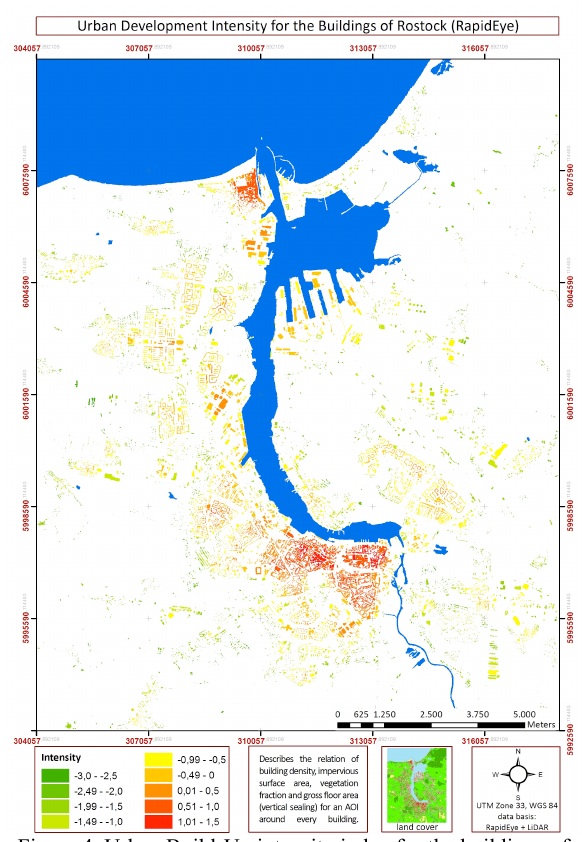
Figure 4. Urban Build-Up intensity index for the buildings of Rostock derived from RapidEye